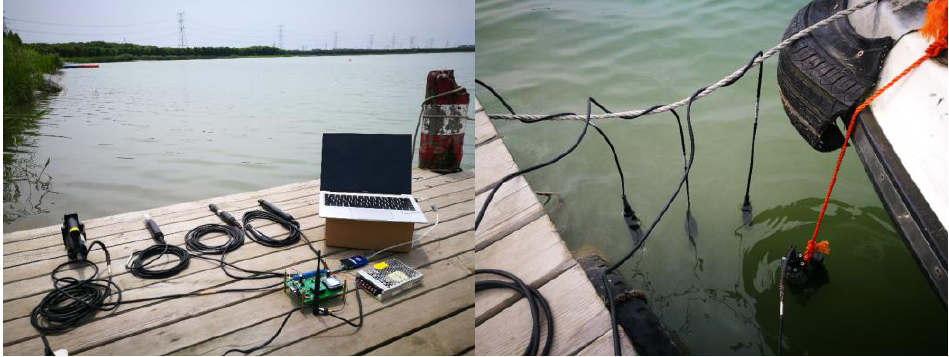
Figure 15. Lake experiment.